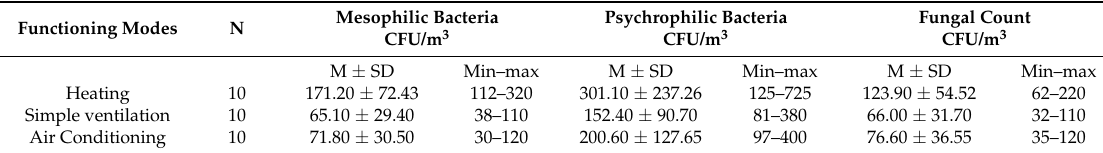
Total microbial concentrations in libraries during heating, air conditioning, and simple